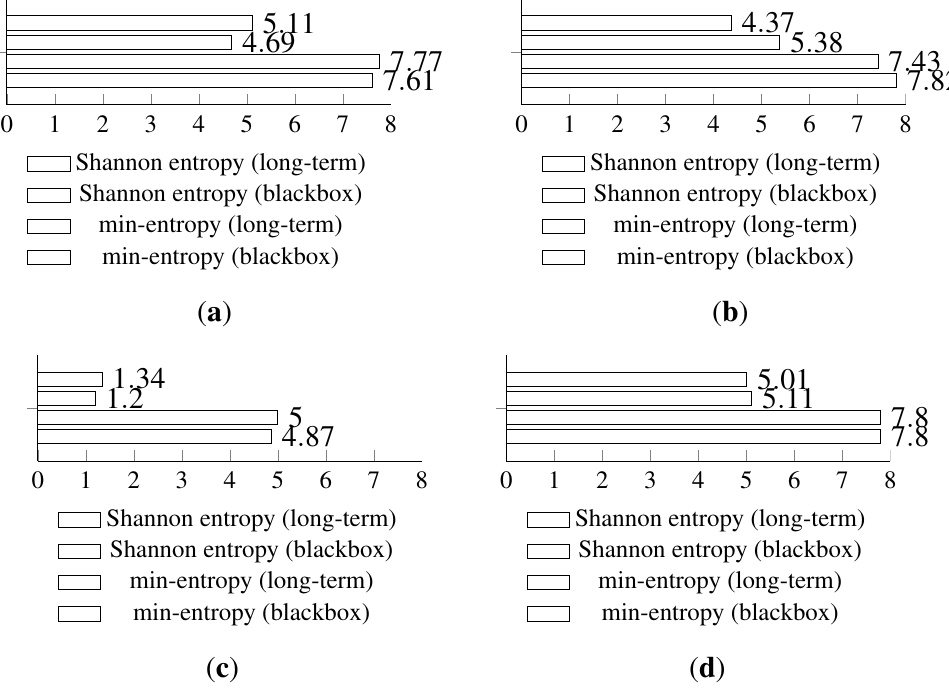
Figure 10. Shannon entropy and min-entropy estimations of the results gathered from the isolation (concatenated results from the alpha and beta devices) and long-term experiments.